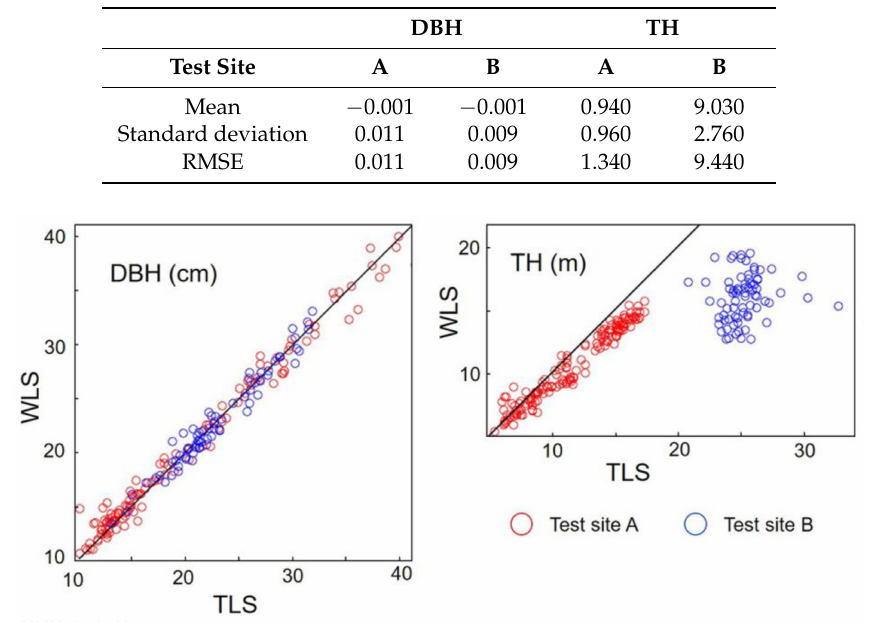
Table 2. RMSE, mean, standard deviation (m) of the differences in diameter at breast height (DBH) and tree height (TH) between terrestrial laser scanning (TLS) and wearable laser scanning (WLS) data at the two test sites.